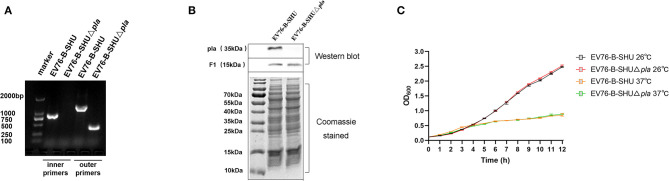
In-vitro biological characteristics of EV76-B-SHUΔpla. (A)
Pla gene identification. The pla gene of the mutant strain was identified through PCR using inner primers (including Pla-inner-F and Pla-inner-R) and outer primers (including Pla-F and Pla-R). (B) Pla and F1 protein expression levels in Y. pestis strains. The whole-cell lysates of EV76-B-SHU and EV76-B-SHUΔpla were separated by SDS-PAGE and stained with Coomassie brilliant blue (lower panel), then probed with Pla- specific polyclonal antibody and F1-specific monoclonal antibody, respectively (upper panel). This picture is a composite of the representative result of multiple samples. (C) EV76-B-SHUΔpla and EV76-B-SHU bacteria were cultured overnight and then diluted to an OD600 of 0.1. The dilutions were cultured in BHI medium at 26°C or 37°C for 12 h. The OD600 value was measured at 1-h intervals.